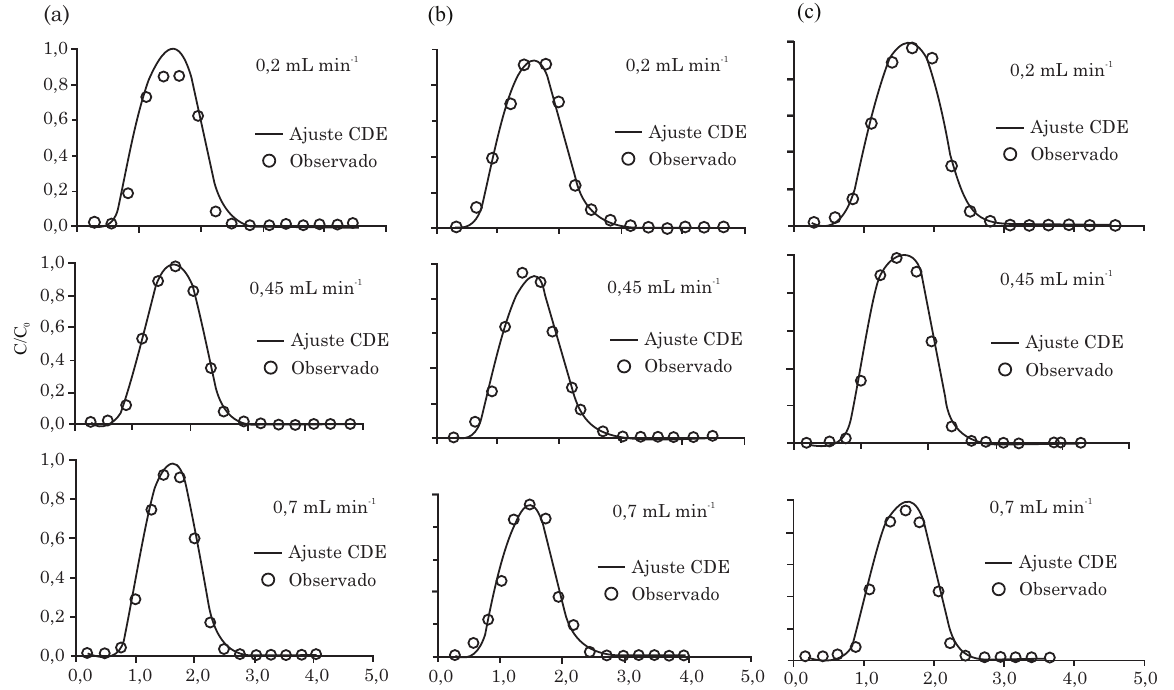
Figura 1. Curvas médias de lixiviação do KBr ajustadas pelo modelo CDE, em colunas de solos Franco- arenoso 1 (a), Franco-arenoso 2 (b) e Franco-argilossiltoso (c), nas vazões de 0,2; 0,45; e 0,7 mL min -1 e na concentração de 1 g L -1